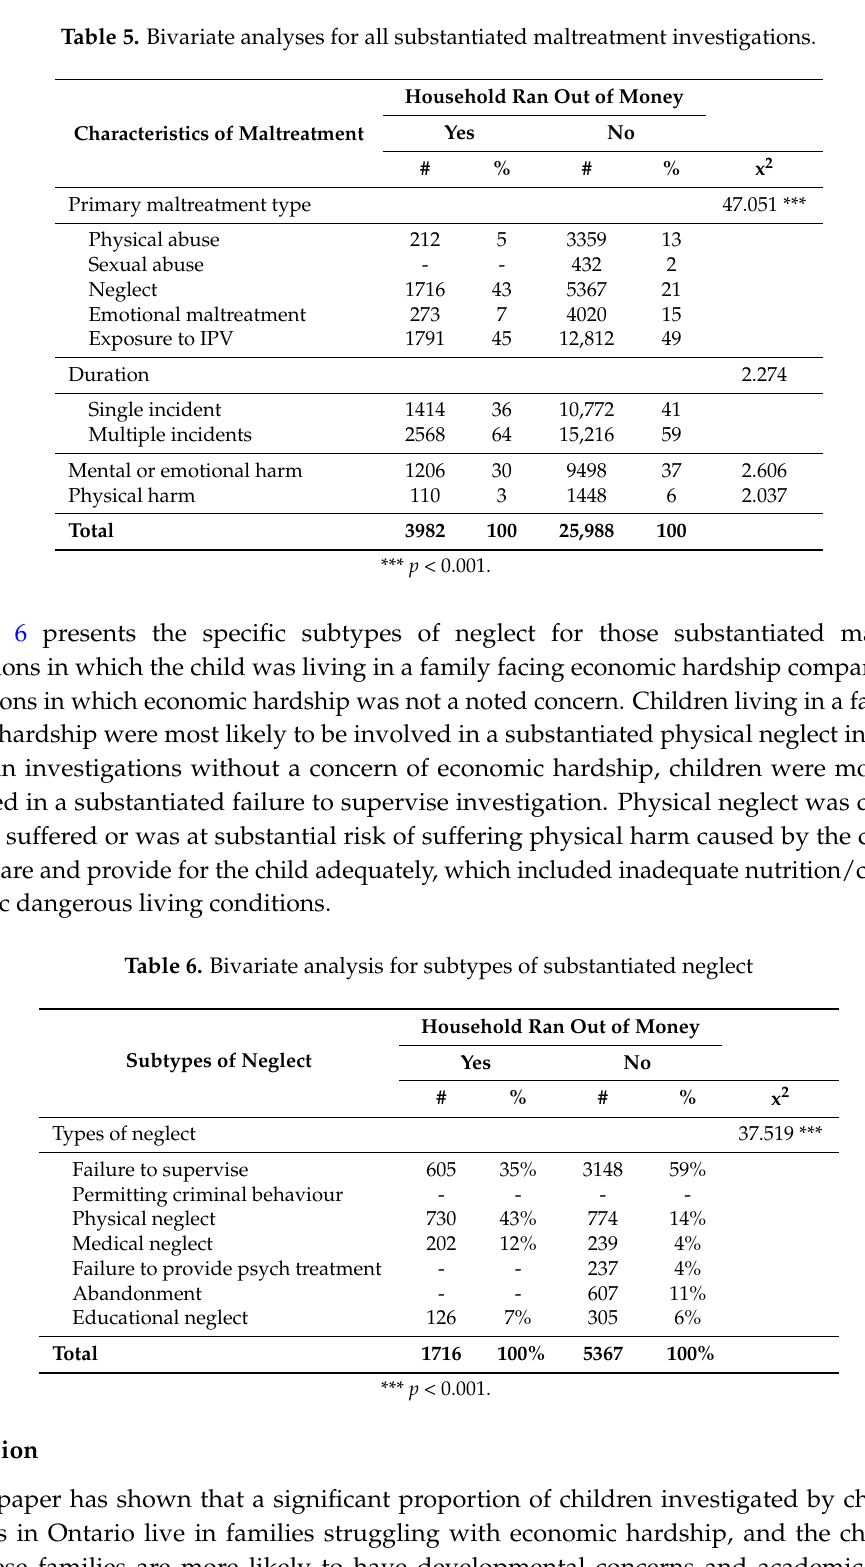
Table 5. Bivariate analyses for all substantiated maltreatment investigations.